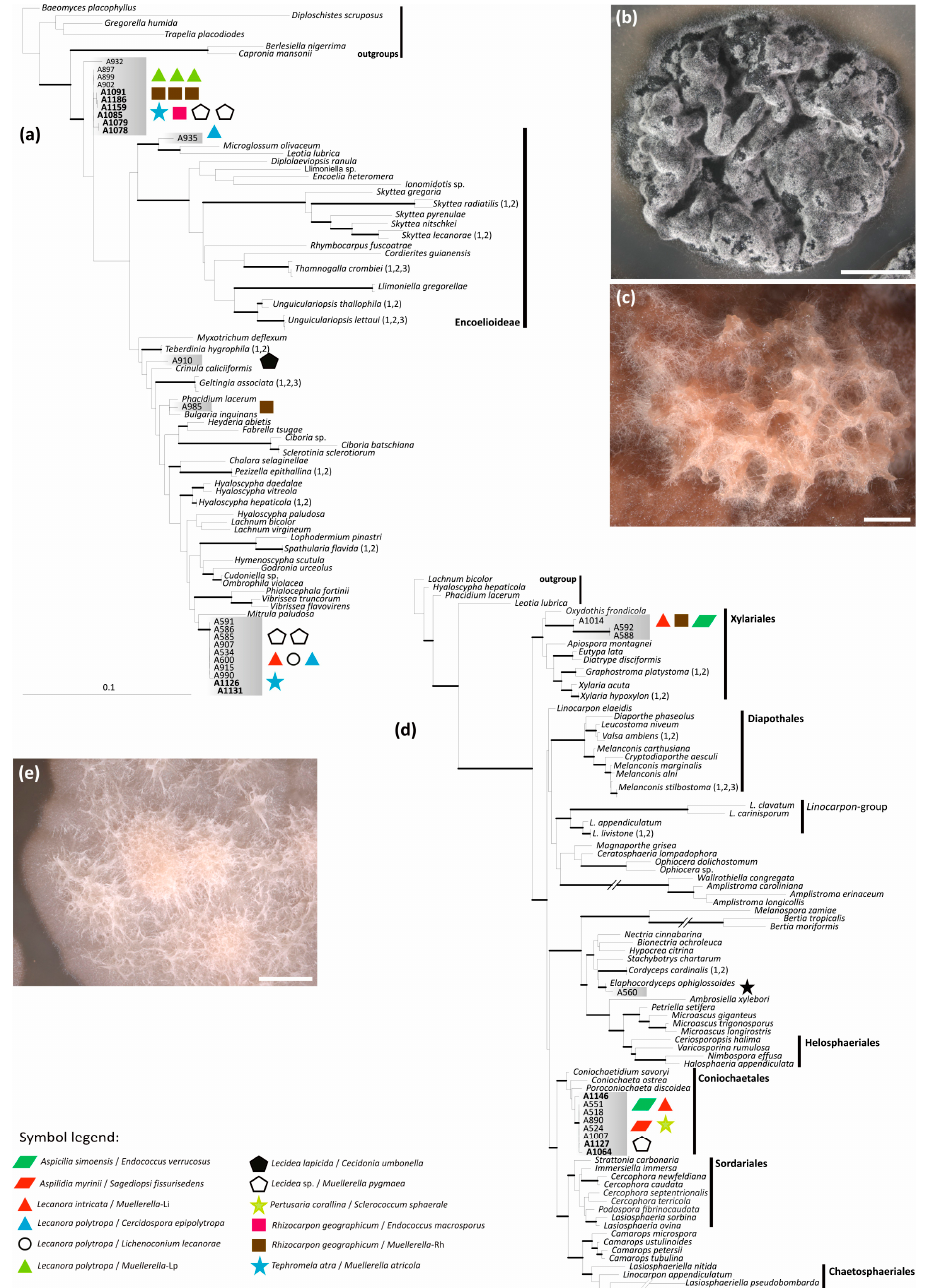
Figure A3. Phylogenetic position of fungal strains belonging to the class Leotiomycetes ( a ) and habit of representative cultured strains: ( b ) A1085 (Leotiomycetes) and ( c ) A1019 (Leotiomycetes). Phylogenetic position of fungal strains belonging to the class Sordariomycetes ( d ) and habit of representative cultured strain ( e ) A518 (Sordariomycetes, Coniochaetales). The symbol legend reported describes the identity of the original samples from which the fungi were isolated: lichen species name/lichenicolous fungus species name infecting that lichen thallus. The isolated strains are reported with their DNA ID number; newly characterized strains are in bold; strains already characterized in Muggia et al. [9] and included in the analyses of growth media are not in bold. The nomenclature of the clades follows Muggia et al. [9]. Fully supported branches (bootstrap support = 100%) are in bold. Scale bar = ( b ) 4 mm, ( c ) 1 mm, ( e ) 2 mm.